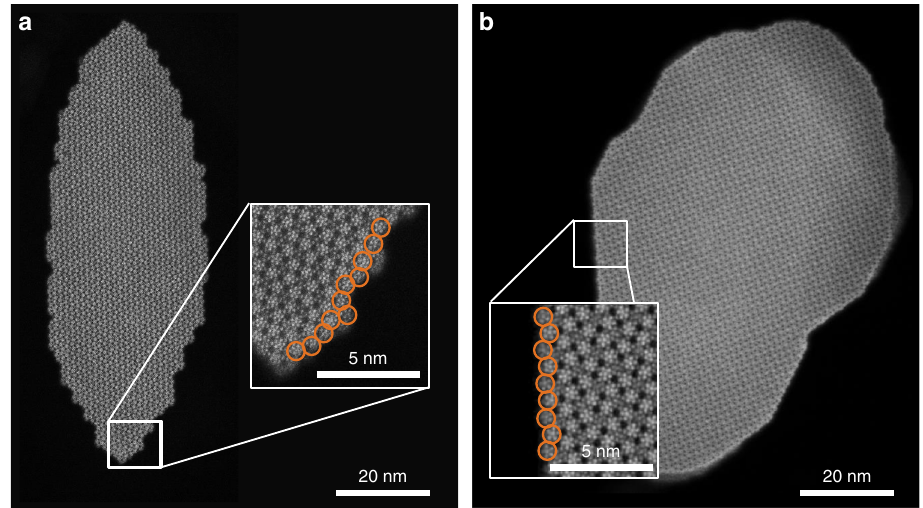
Fig. 4 ADF-STEM images of {001} plane of M1 MoVTeNbO x particles. Sample prepared by the new synthesis method, after drying overnight in air at 80 °C ( a ) and sample prepared by the method in ref. 19 , followed by crystallization at 650 °C in inert ( b ). Insets show representative lateral surface termination. Circles highlight complete pentagonal M 6 O 21 units observed near the termination